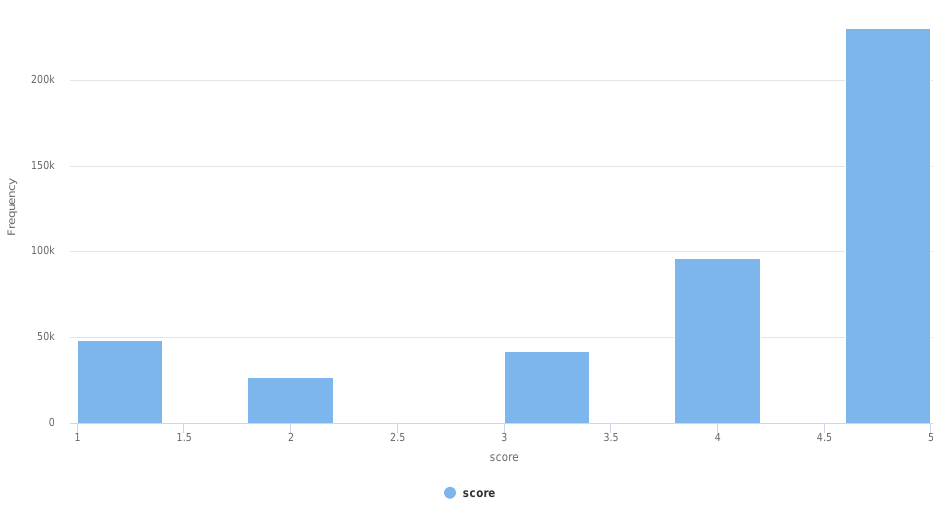
Figure 14. Overall user rating on reviews.